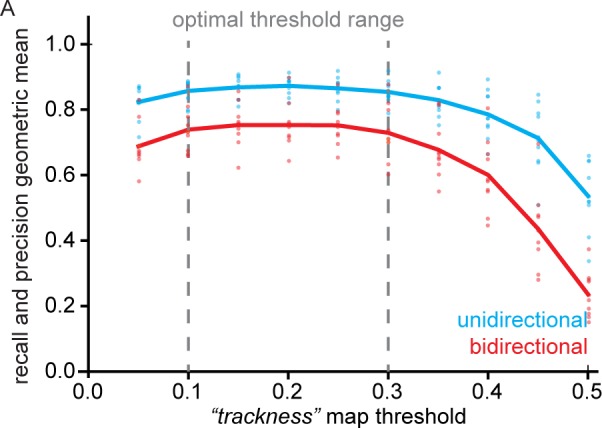
Geometric mean of track recall and precision for different trackness thresholds.(A) 10 synthetic unidirectional and bidirectional kymographs were analysed with varying trackness thresholds, and track recall and track precision were calculated. The geometric mean of recall and precision does not exhibit much variation between 0.1 and 0.3 but decreases at lower and higher values. Individual dots represent per kymograph values and the solid lines the binned mean.